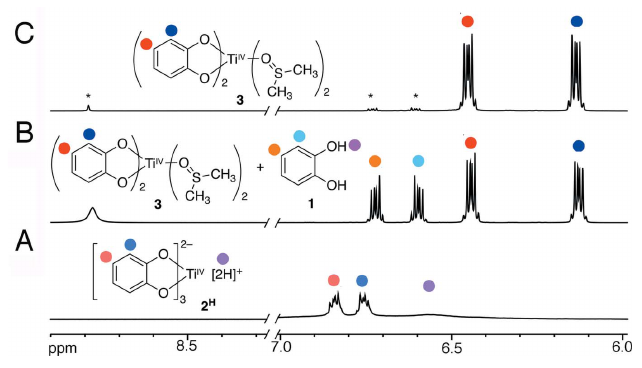
Figure 2 1 H NMR spectra (400 MHz, DMSO- d H dissolved at 6 ) of ( A ) complex 2 ambient temperature; ( B ) of complex 2 H at (cid:4) 373 K, showing the presence of complex 3 and free catechol 1 ; ( C ) of isolated crystals of 3 precipitated from DMSO at ambient temperature (* indicates the presence of residual 1 ).